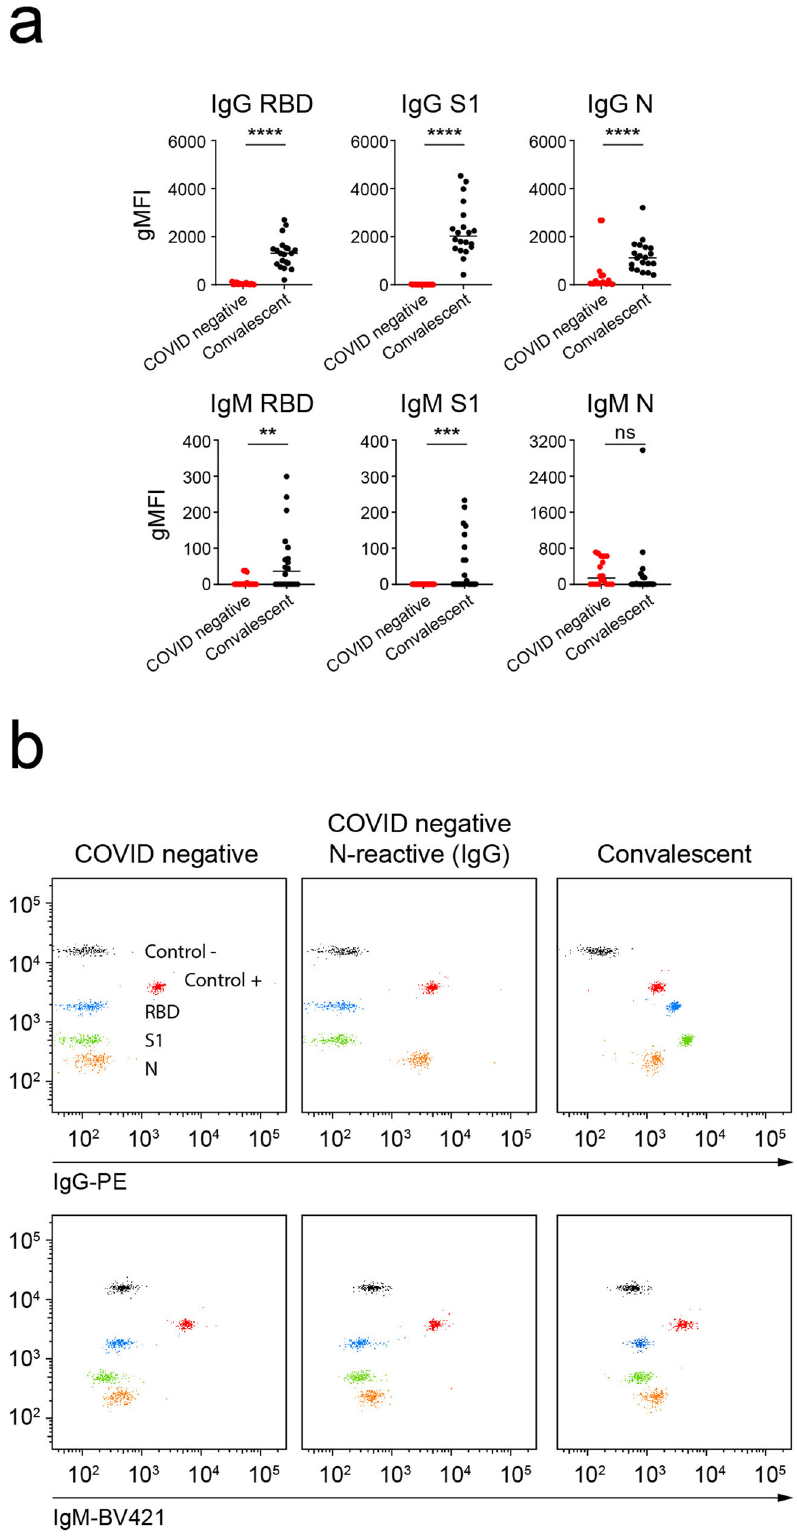
Fig. 6 C19BA identi fi es IgG and IgM seroconversion in a cohort of samples from convalescent donors, and the presence of N-reactive IgG antibodies in Covid-seronegative samples. a Serological responses against RBD, S1, and N measured by C19BA on serum samples ( n = 38) from convalescent patients after at least 1 month of disease onset, IgG (top) and IgM (bottom) are shown. b Representative dot plots obtained by C19BA showing IgG (top) and IgM (bottom) levels, as indicated. Statistical analyses were performed using an unpaired two-tailed Student ’ s t -test. Asterisks represent p values (**** p < 0.0001, *** p < 0.001, ** p < 0.01). Horizontal lines represent median